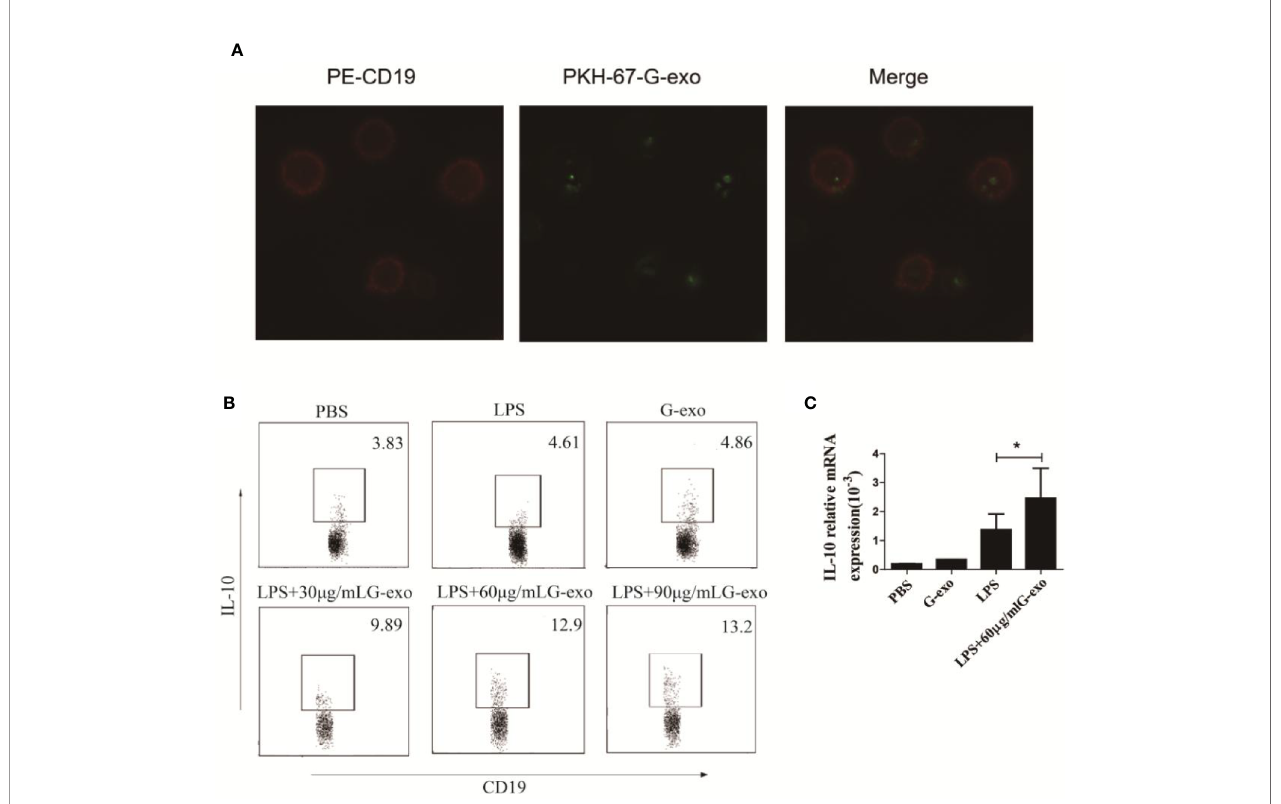
FIGURE 4 | G-exo promote the generation of IL-10 + B cells in vitro . (A) Representative confocal microscopy images of B cells treated with PKH-67 (green)-tagged G-exo for 6 h. Cells were stained with the PE-anti CD19 mAb for the membrane. (B) Splenic B cells were cultured with LPS (10 m g/ml), G-exo (30 m g/ml), or with a combination of LPS and different concentrations of G-exo for 48 h. IL-10 – producing B cells were analyzed by FCM. (C) Levels of IL-10 mRNA were determined by RT-qPCR. Bar graphs show the means ± SD. *P < 0.05. The presented data are from one of three independent